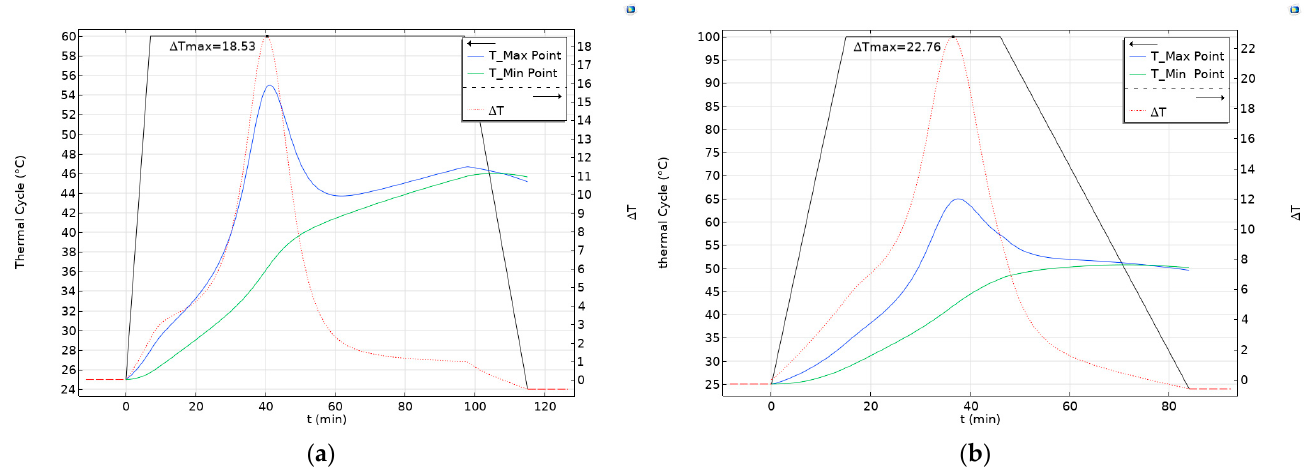
Figure 15. Temperature profile inside the part for the hottest and coldest points and their gradient for the cycle at Tmax equal to 60 °C ( a ) and 100 °C ( b ).